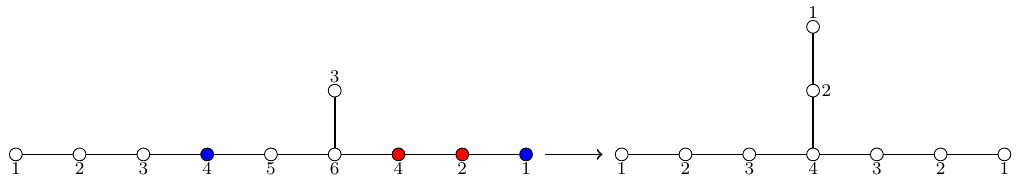
Figure 3. The SU(8) × SU(2) preserving mass deformation of the rank 2 SO(16) × SU(2) theory. We turn on FI parameters at red nodes. As a result of the higgsing a new U(2) node appears, coupled to the blue